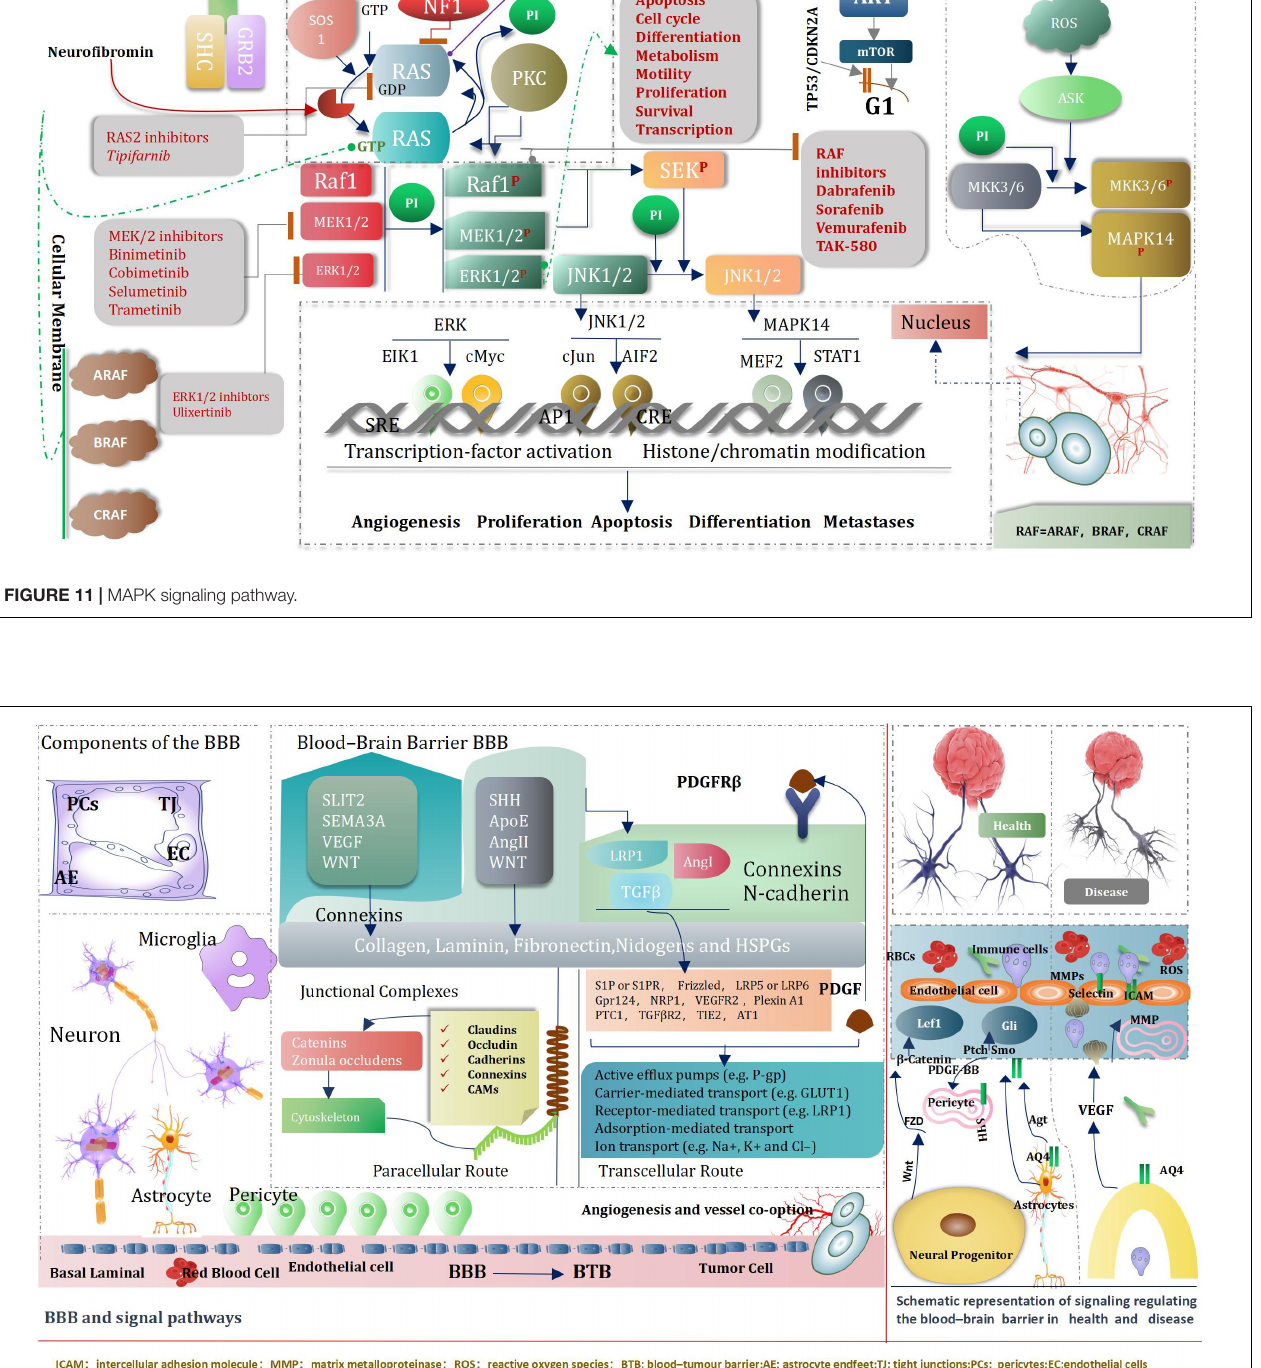
FIGURE 12 | BBB and signal